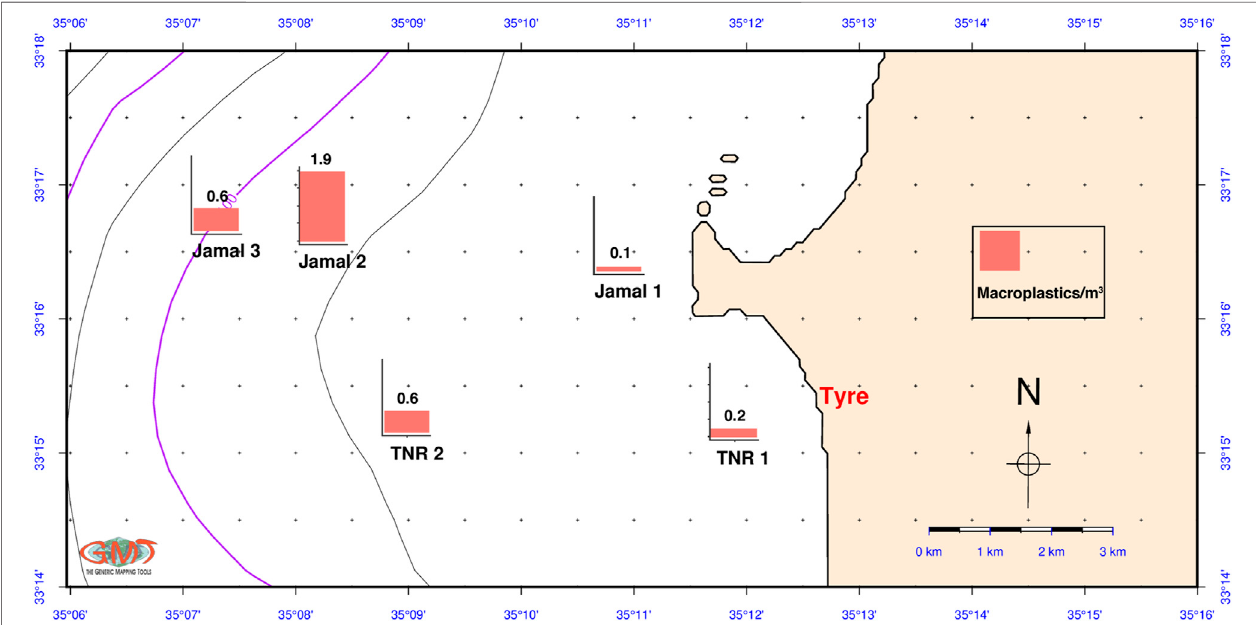
FIGURE 3 | The distribution and concentration (items/m 3 ) of macroplastics in Tyre marine area.